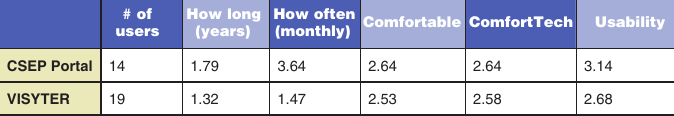
CSEP Portal and/or VISYTER Note. Five participants used VISYTER only and not the portal. No one used only the portal. Comfortable, ComfortTech, and Usability were rated on a scale of 1 to 7, with lower scores indicating increased